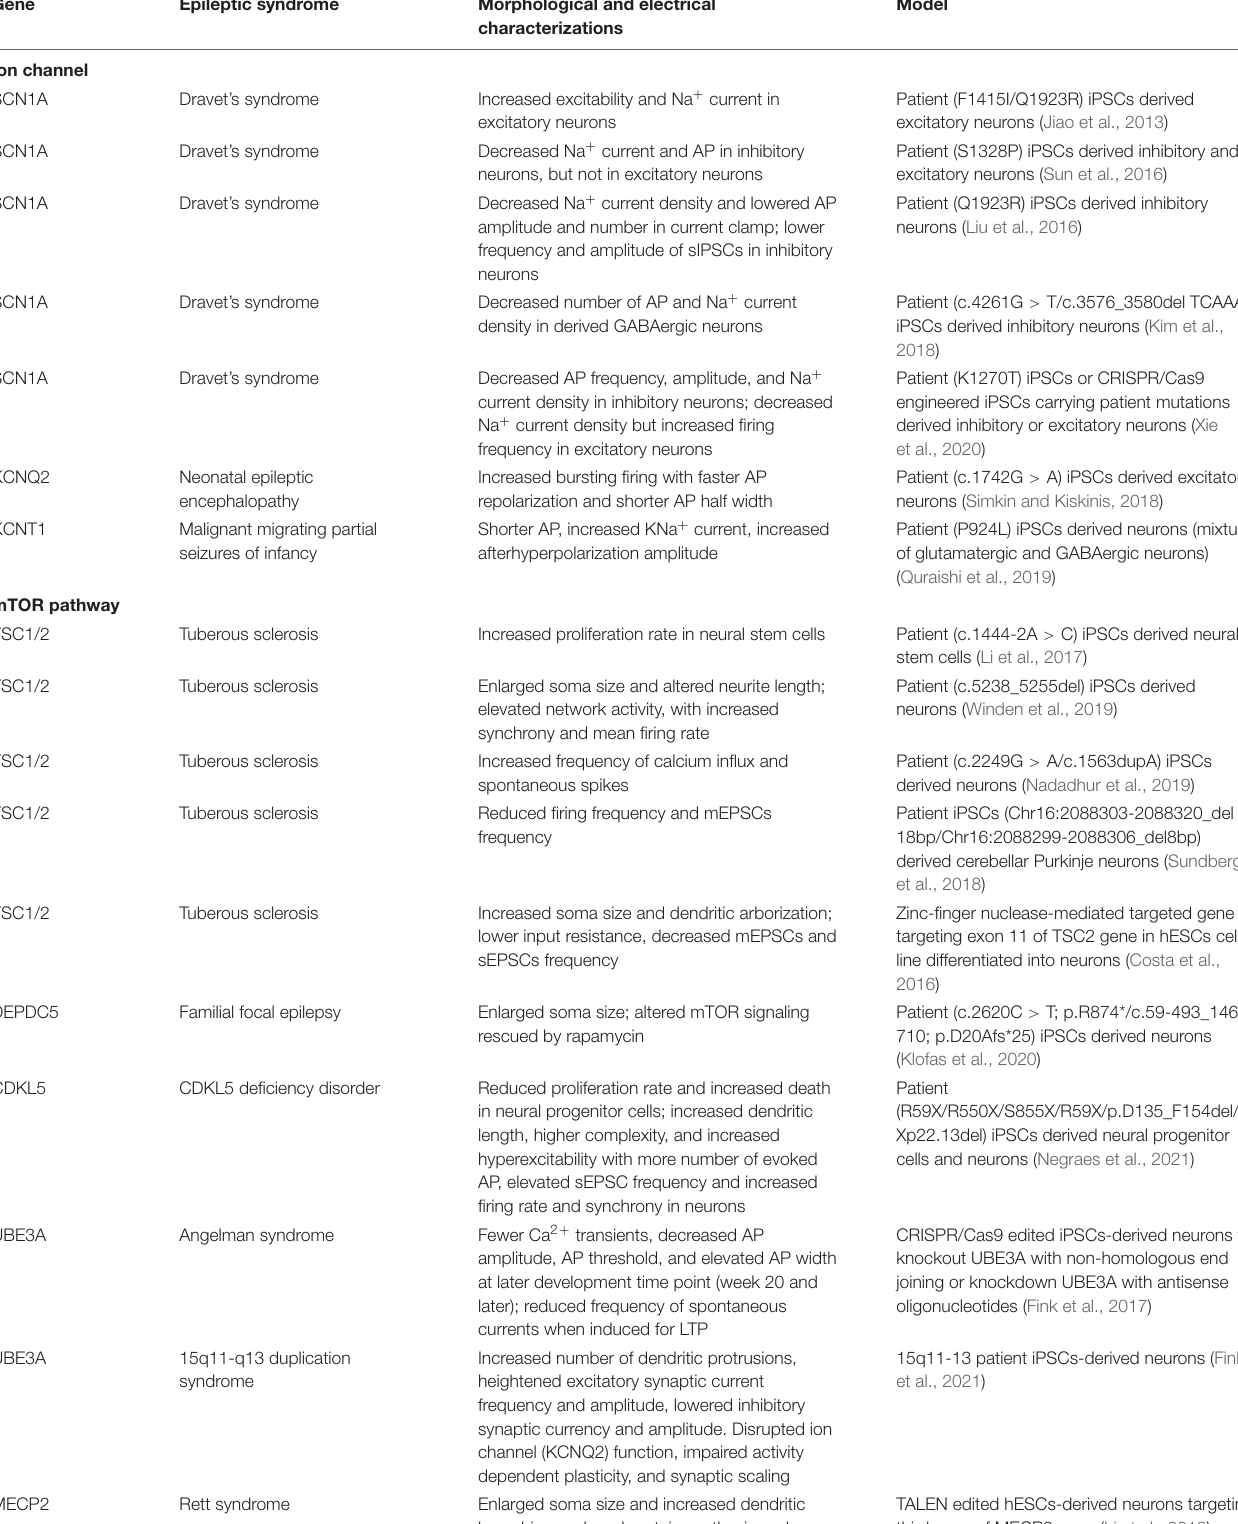
TABLE 1 | Summary of human iPSC-derived cultures on epilepsy related to ion channels and mTOR pathway mutations. Gene Epileptic syndrome Morphological and electrical